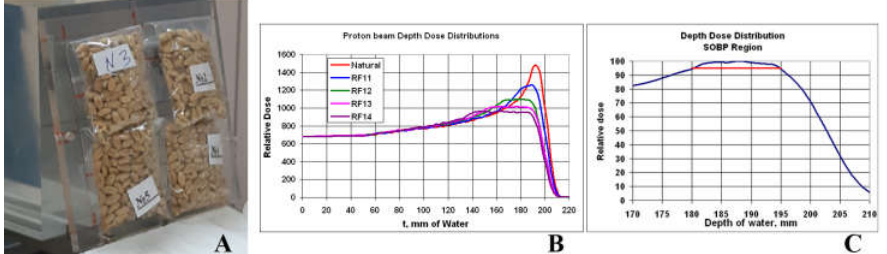
(t- absorption thickness). ( C ). Region of the sample irradiation—depth of 180 mm of water.